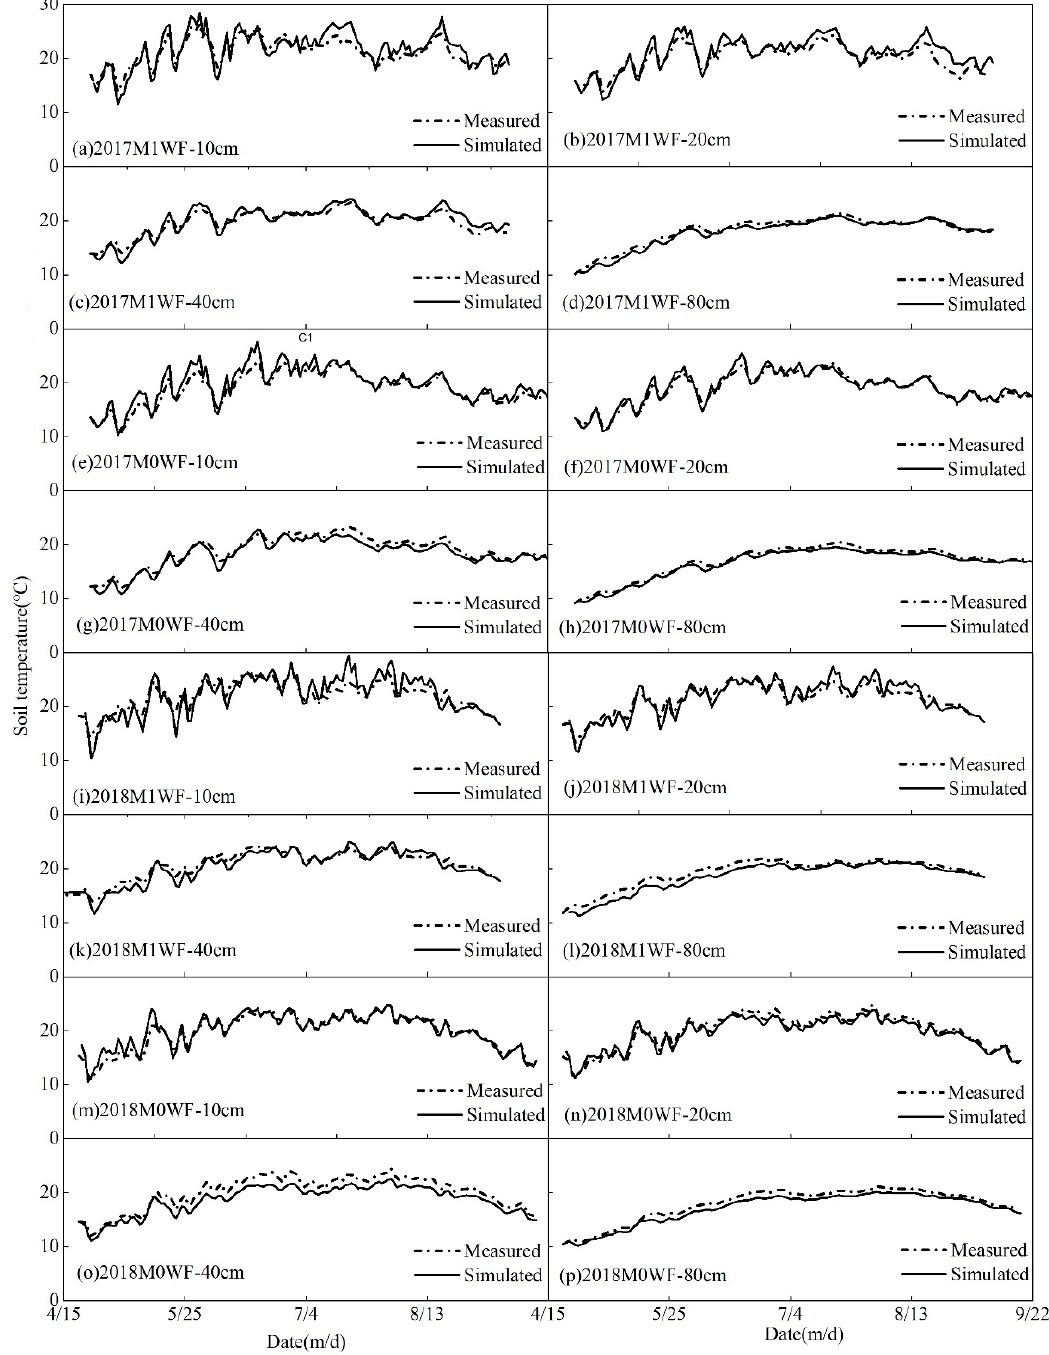
Figure 3. Comparison of the simulated and measured average daily soil temperature at 10, 20, 40, and 80 cm soil depths under M1WF and M0WF treatments during the whole growth period in 2017 ( a – h ) and 2018 ( i – p ).